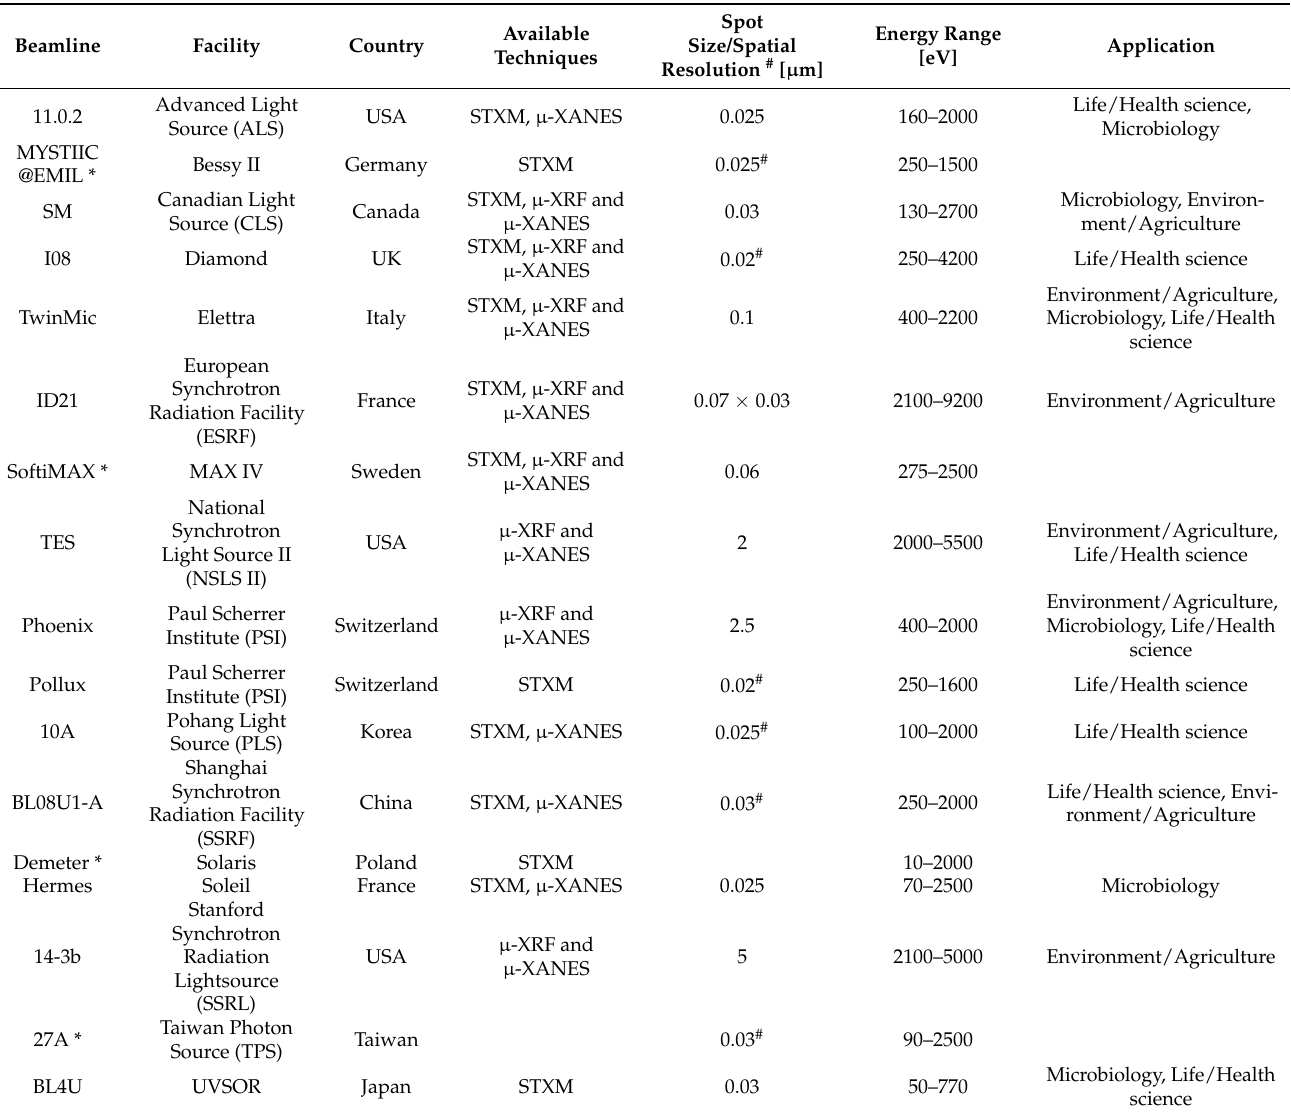
Table 1. List of synchrotron soft X-ray beamlines suitable for research on metabolism. In the table are indicated some specifics for each beamline. The application field refers to previous publications correlated to